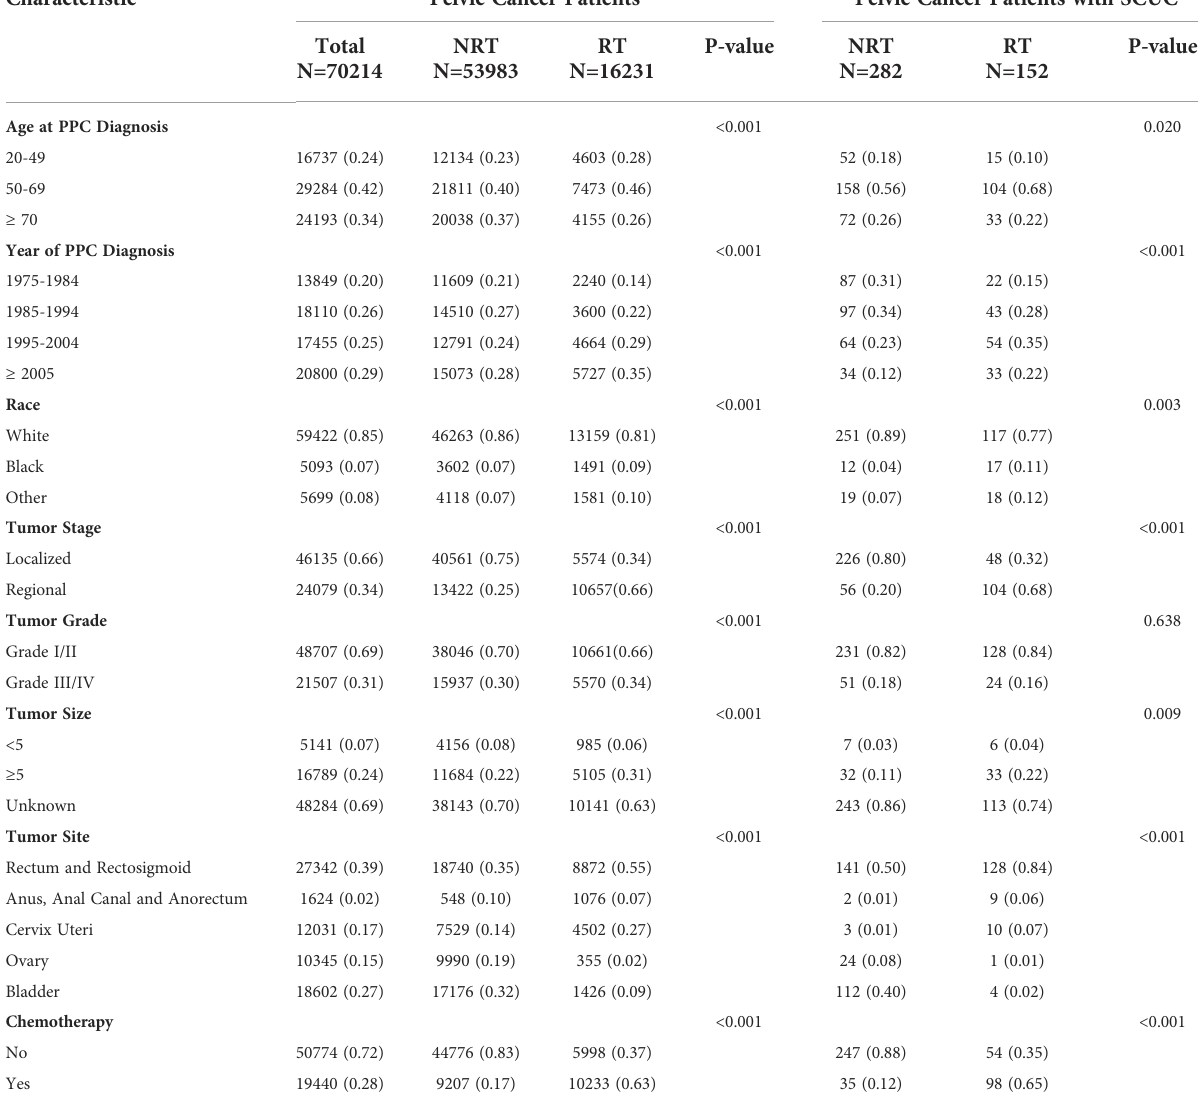
TABLE 1 Comparisons of Baseline Characteristics of Patients with PPC by Treatment Modality.